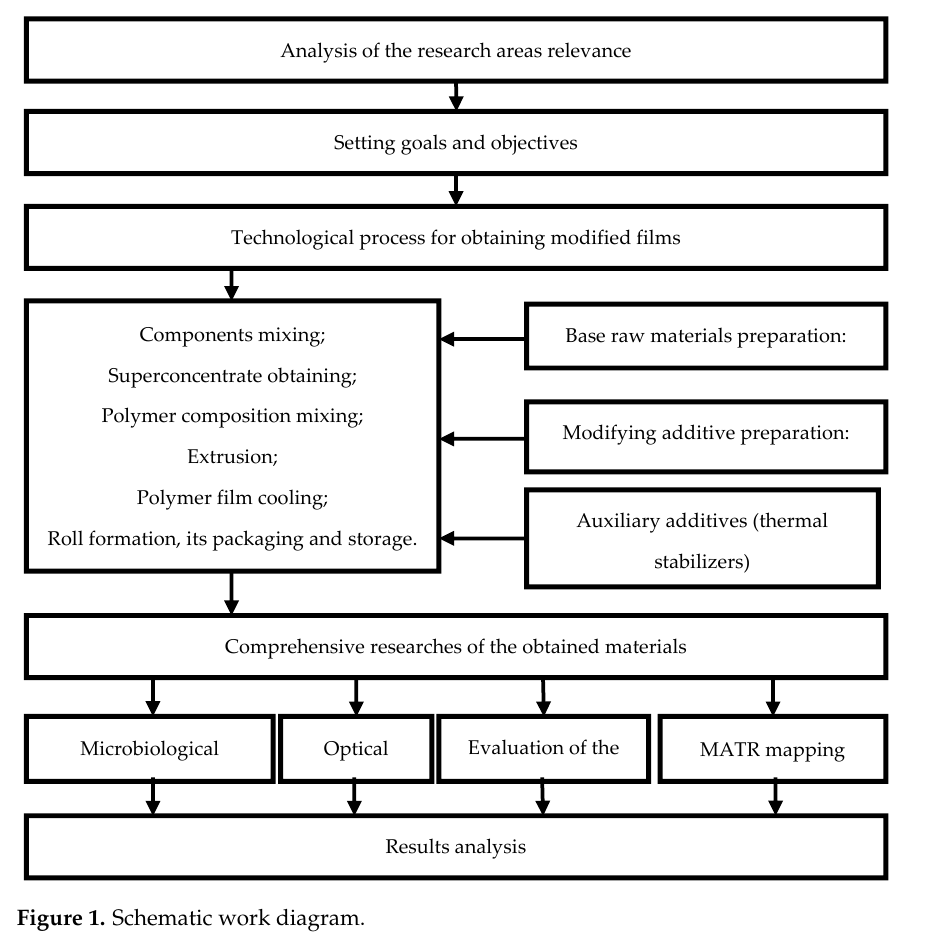
Figure 1. Schematic work diagram.